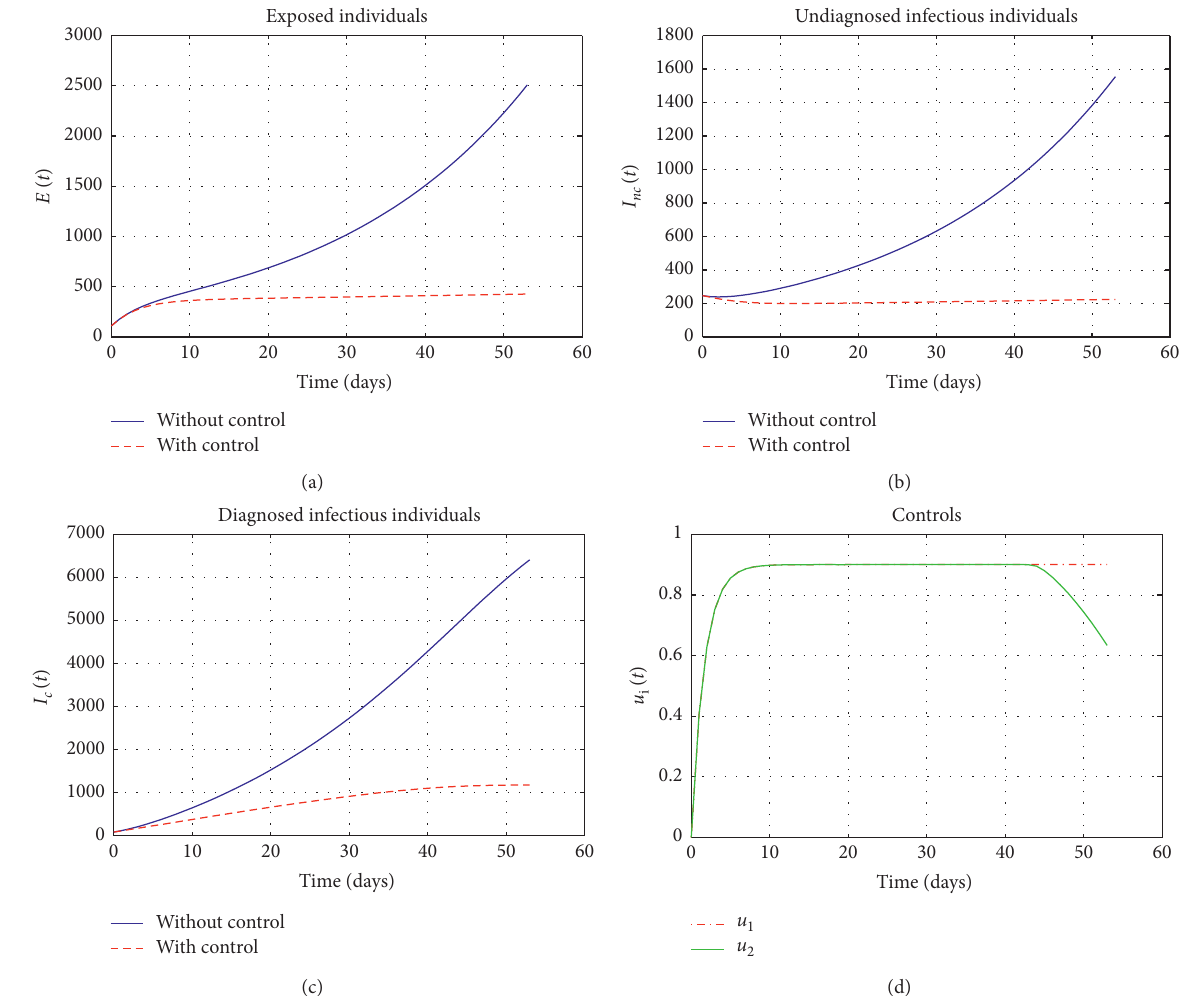
Figure 5: Number of E , I infectious individuals ( I nc ). (c) Confirmed and isolated individuals ( ( I c ) ). (d) Evolution of the controls u d � 0 . 02, α � ( 0 . 6 , 0 . 6 ) , σ � 1, and u max